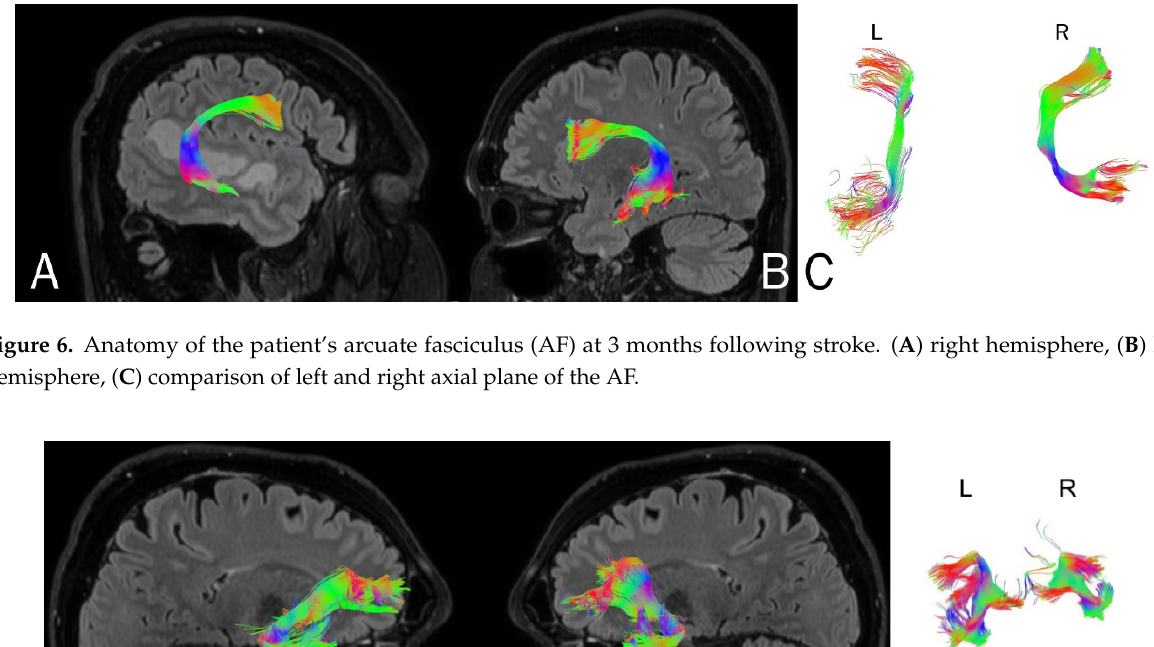
Figure 5. Anatomy of the uncinate fasciculus (UF) upon the patient’s admission to the hospital. ( A ) right hemisphere, ( B ) left hemisphere, ( C ) comparison of left and right axial plane of UF.